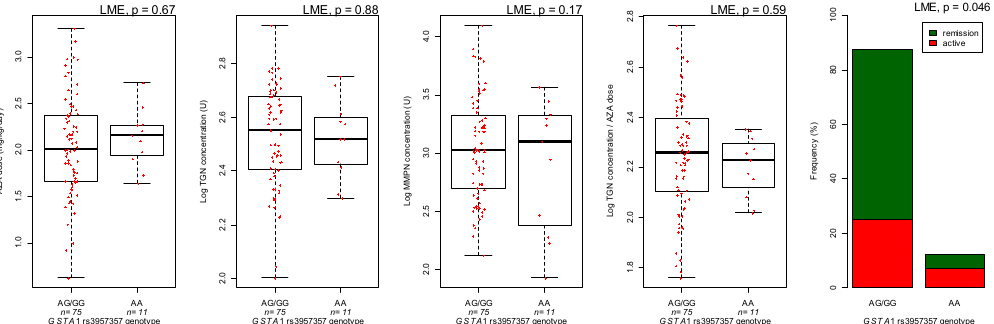
GSTA1 variant (12.8% of patients) showed a trend for an association with decreased clinical efficacy (LME p = 0.046, Figure 4); however, no significant effect on azathioprine pharmacokinetics could be detected (Figure 4).